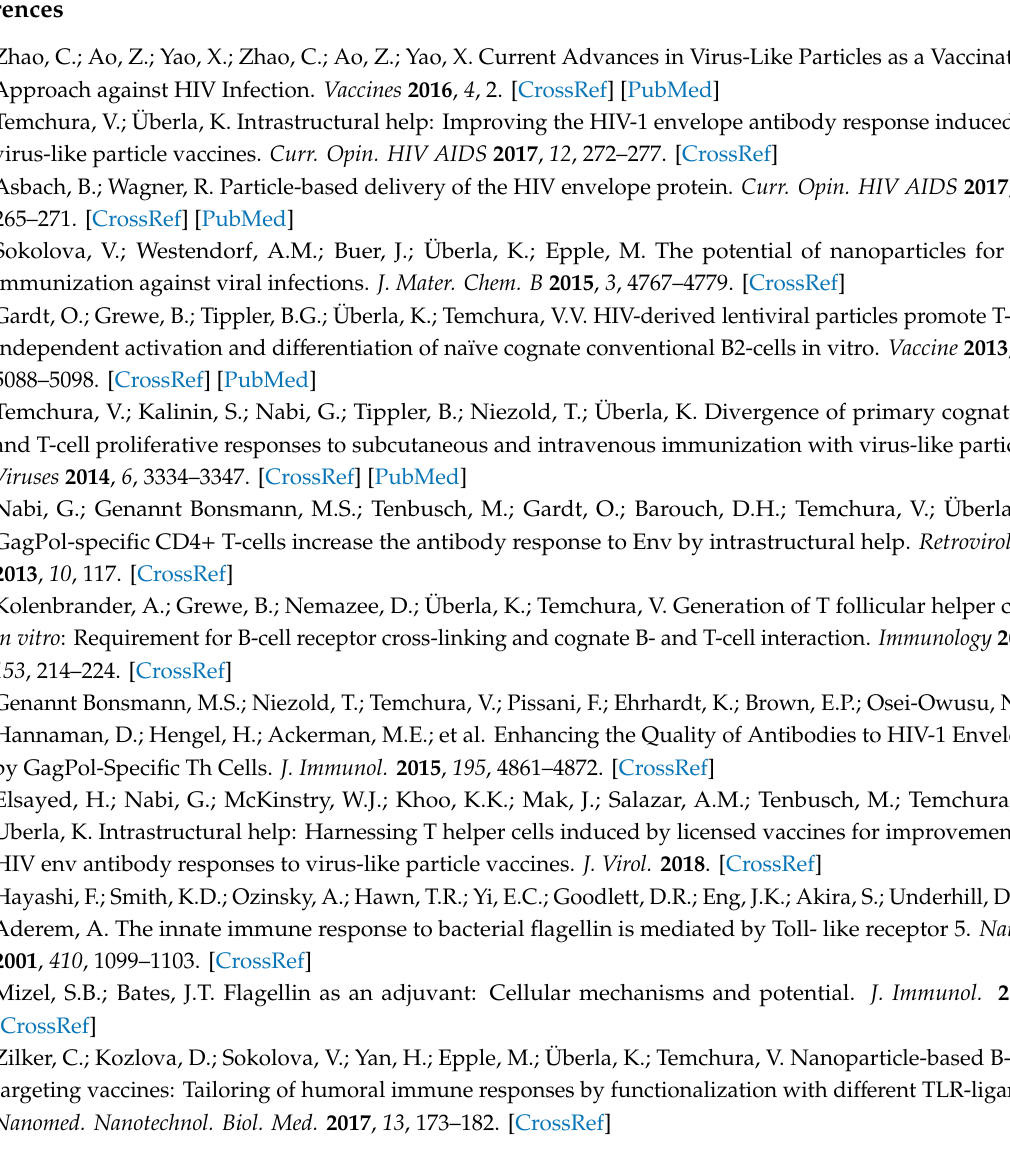
Figure A2. Immunogenicity of Env-VLP nano-vaccines functionalized with KF ∆ (serological follow up). For serological follow up, Wt Balb / c mice were immunized i.m. three times: at days 0, 35, and 56 with either Env-VLP or Env-VLP-KF ∆ containing 400 ng HIV-Env / mouse. The sera samples were obtained at days 63 and 77. Humoral immune responses against HIV-Env were measured in 1:100 diluted sera samples and expressed as log10-transformed relative light units per second (RLU / s log10). The columns represent the mean values ± SEM.